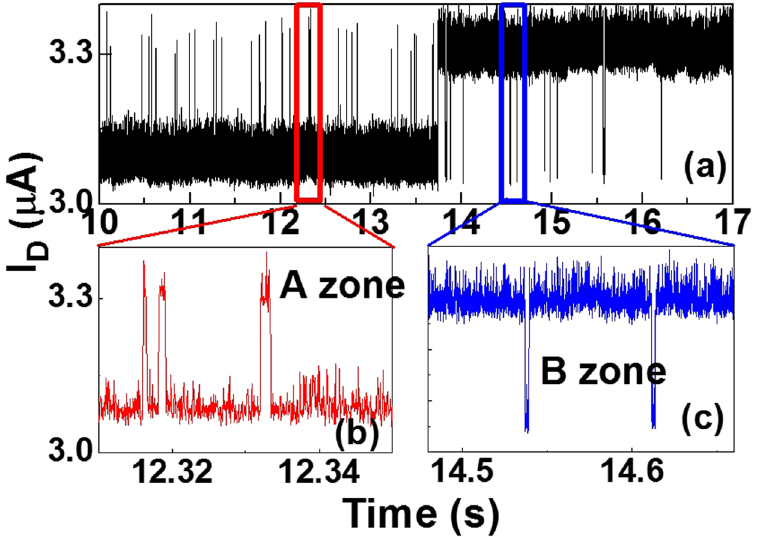
Figure 3. A closer view of the rRTN under V G = 0.5 V in zone A and zone B separately. The emission time constant ( τ